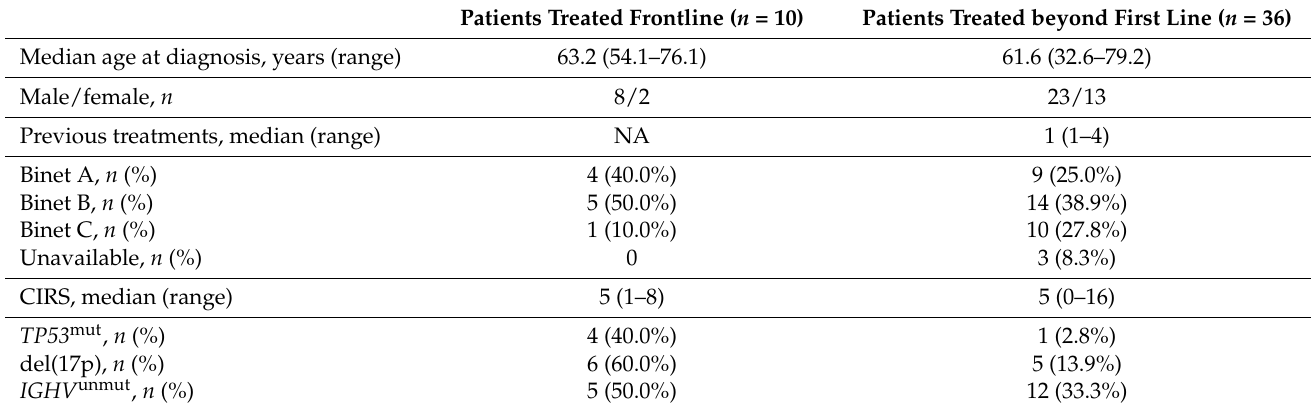
Table 1. Patient characteristics according to treatment